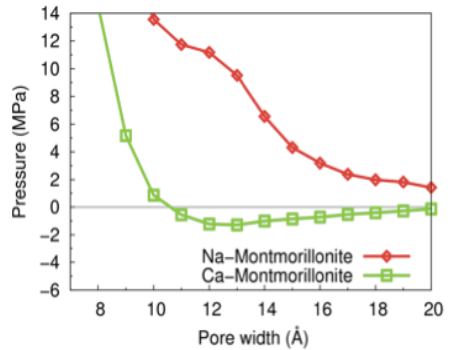
Figure 4: Interlayer pressure computed with the Primitive Model versus pore width for montmorillonite with sodium (red diamond symbols) or calcium (green square symbols) interlayer cations